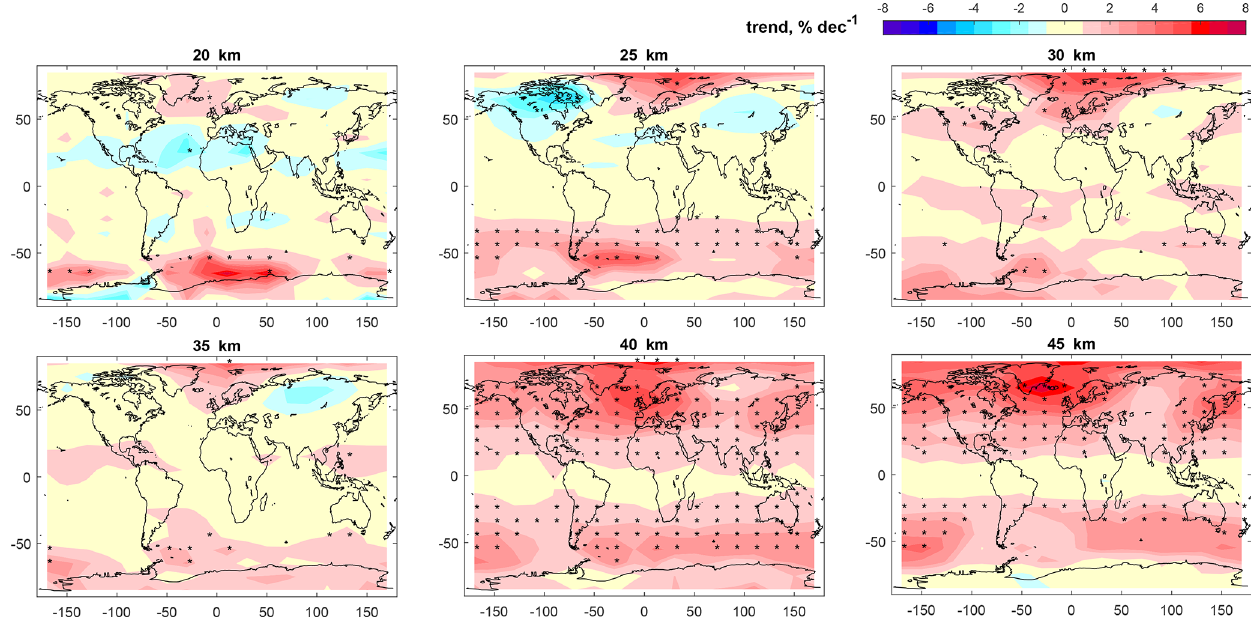
Figure 10. Ozone trends (%decade − 1 ) in 2003–2018 for several altitudes. Statistically significant trends are indicated by stars.